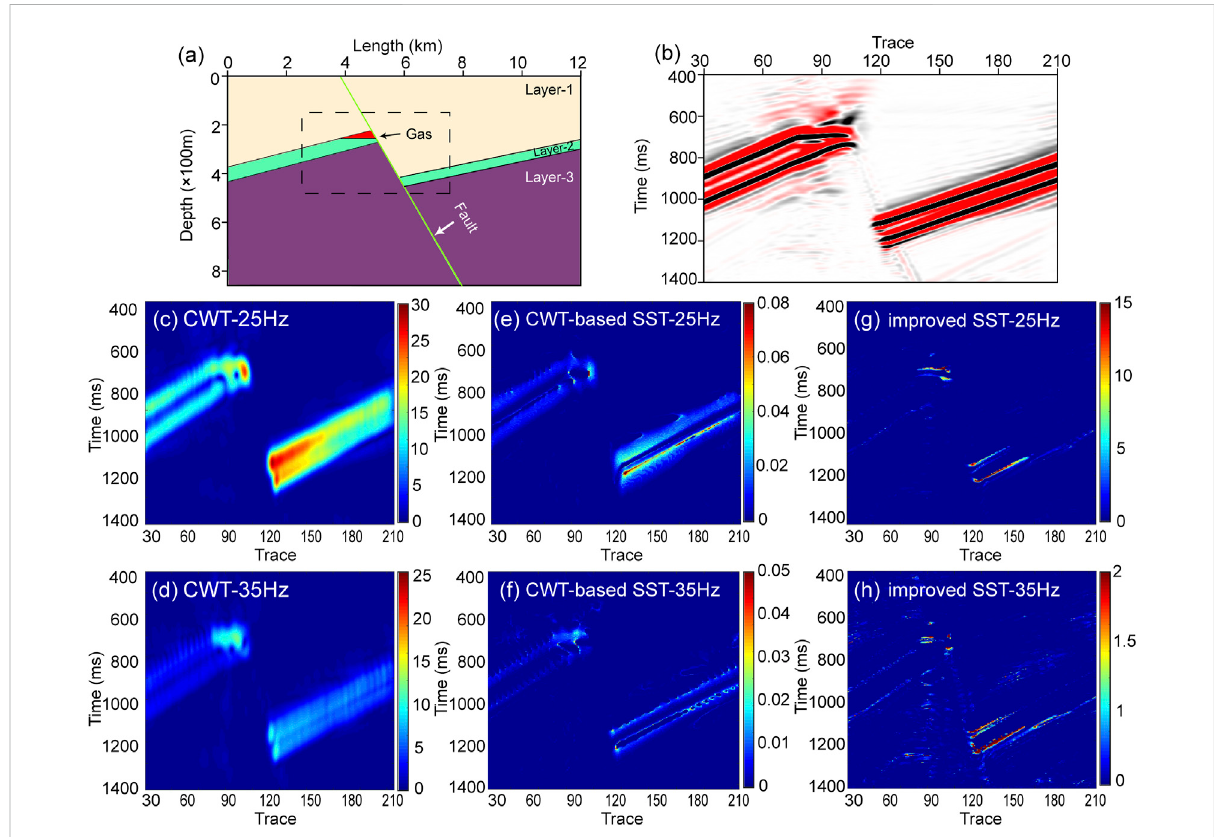
FIGURE 5 Application of the 2-D non-horizontal model and analysis of the instantaneous frequency used the isofrequency section. (A) Forward model, which is created by using the Tesseral 2-D; the black dotted box shows the location of the pro fi le in Panel (B) ; (B) pre-stack time migration pro fi le of the 2-D forward model in Panel (A) . (C) 25 Hz-isofrequency section of the continuous wavelet transform (CWT); (D) 35 Hz-isofrequency section of the CWT; (E) 25 Hz-isofrequency section of the CWT-based SST; (F) 35 Hz-isofrequency section of the CWT-based SST; (G) 25 Hz- isofrequencysectionoftheimprovedsynchrosqueezingtransform(SST)inthisstudy; (H) 35 Hz-isofrequencysectionoftheimprovedSST(theseare all plotted with MATLAB, with the “ jet ” colormap; red indicates higher amplitude).